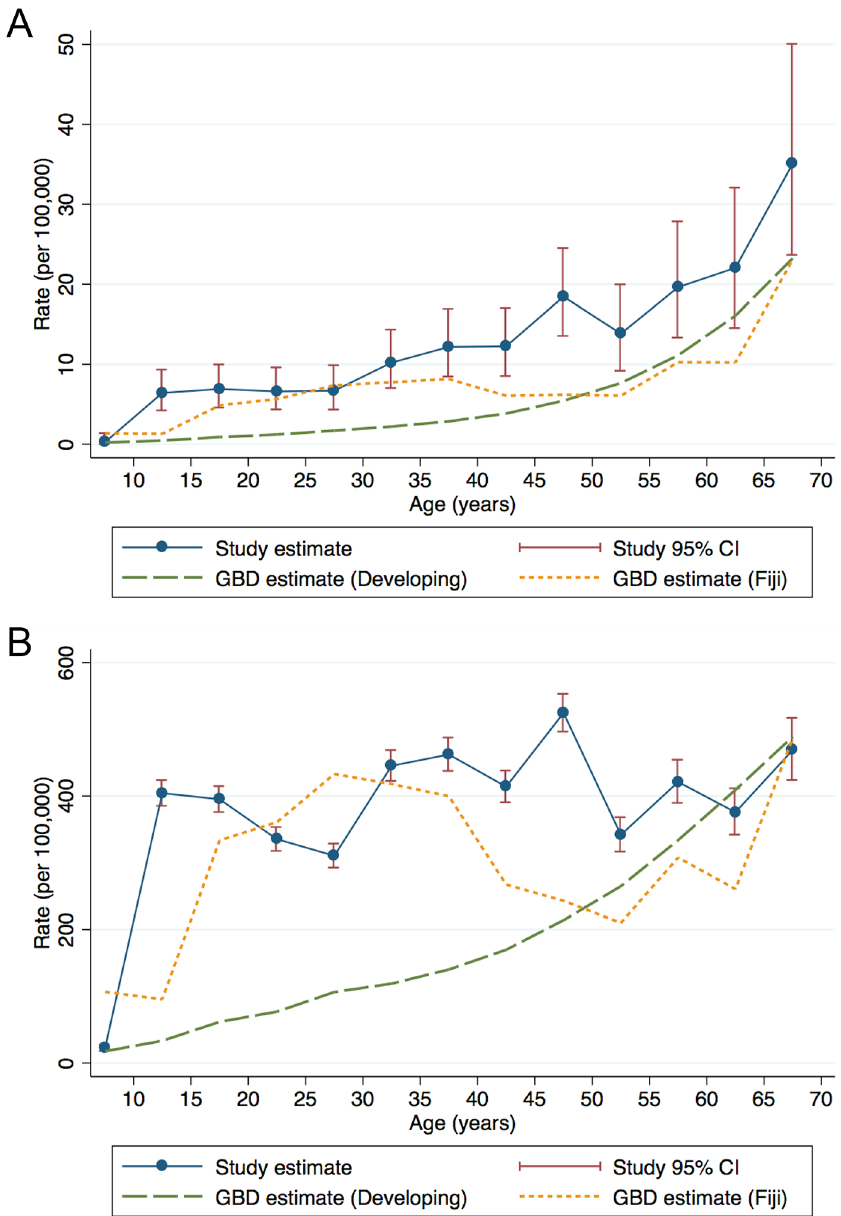
Fig 3. Estimated RHD-attributable death rates at ages 5 – 69 in Fiji, 2008 – 2012. A: Death rate, B: YLL rate. Both are plotted at mid-point of age group. Global Burden of Disease (GBD) project estimates for 2010 for all developing countries and for Fiji are plotted for